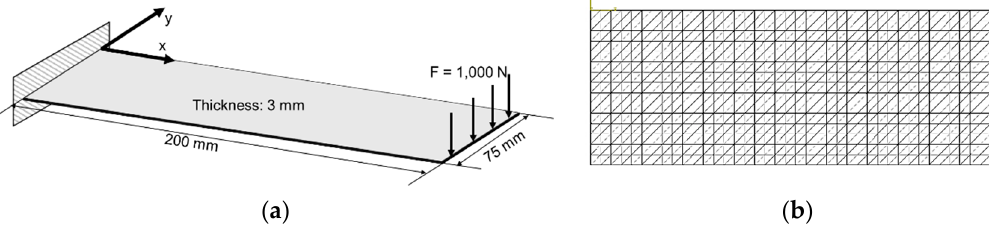
Figure 1. Minimisation of the plate’s maximum absolute deflection: Plate geometry, boundary conditions, and applied load ( a ). Discretisation of plate geometry with 1200 S3 elements ( b ).